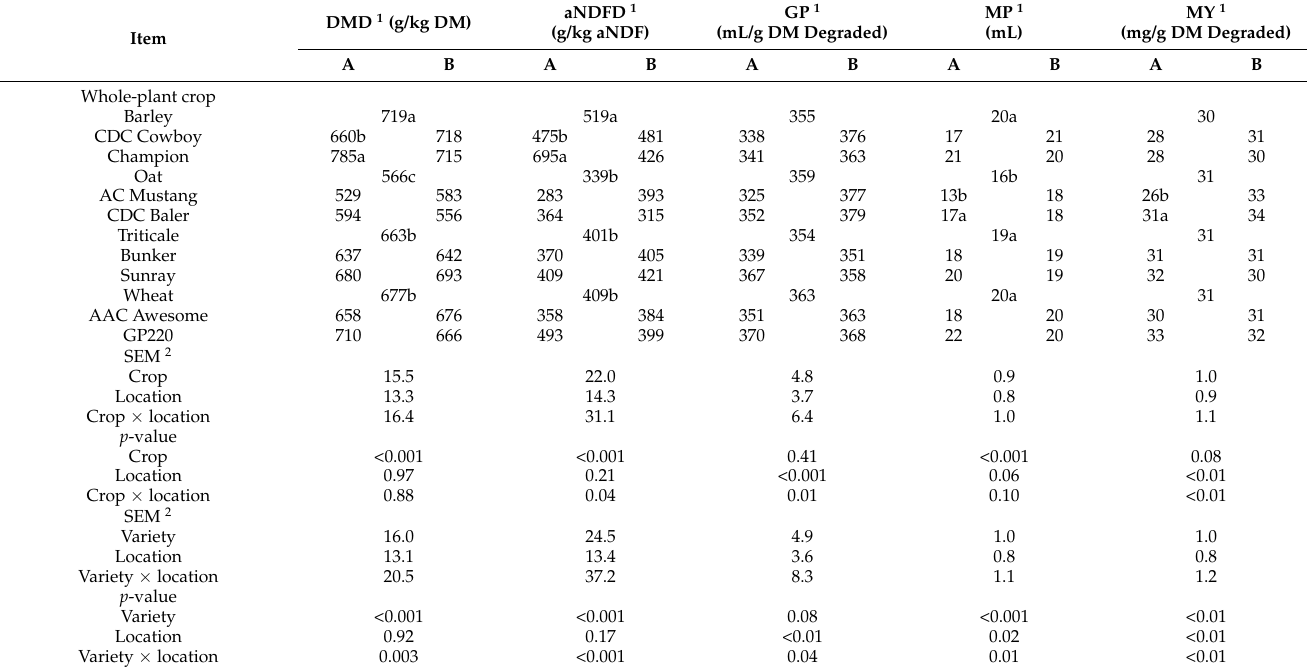
Table 2. In vitro dry-matter degradability (DMD), neutral detergent fiber degradability (aNDFD), accumulated gas produced (GP), methane yield (MY), and methane production (MP) after 48 h for whole-plant cereal crops grown and harvested at two locations (A, B) in central